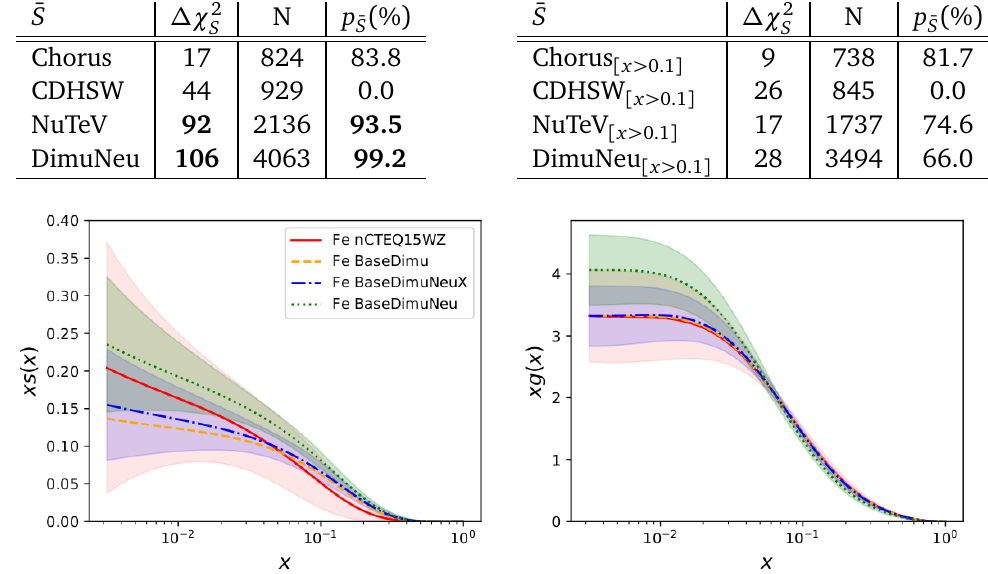
( % ) after Table 2: Same as Table 1, but with the x ≥ 0.1 S cut imposed.